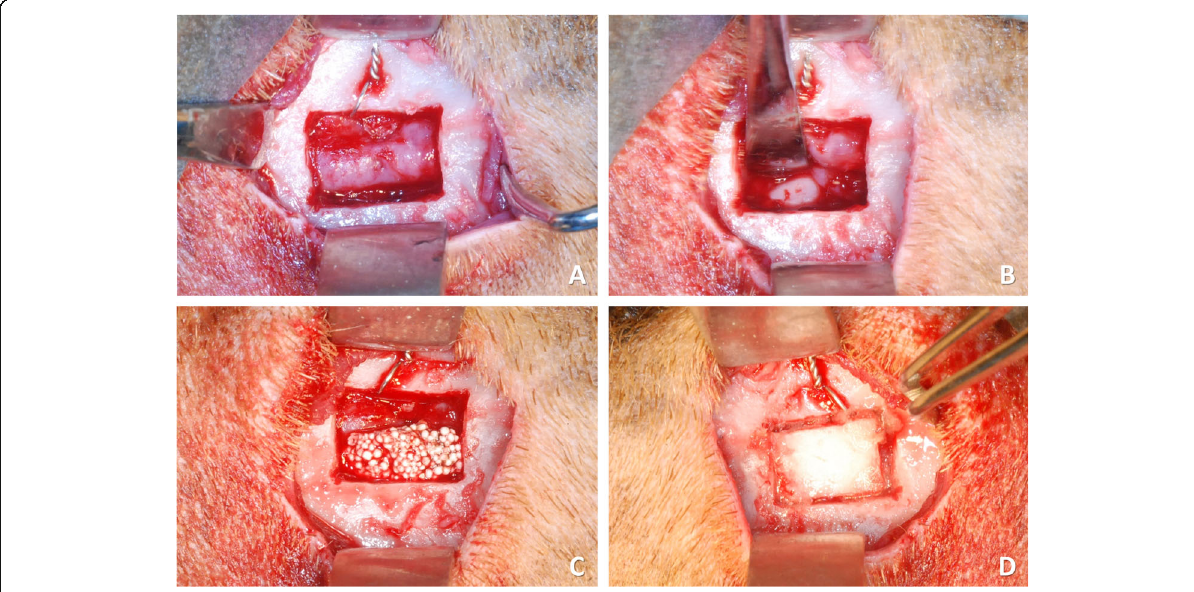
Fig. 2 Clinical view at a bone plate site. a The bone window was removed. b The sinus mucosa was carefully elevated, and a twisted wire was placed. c The elevated sinus was grafted. d The access bony window was repositioned and secured with